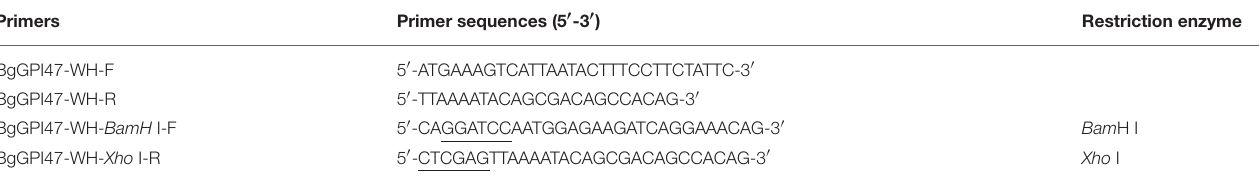
TABLE 1 | Primers used for the amplification of the partial BgGPI47-WH